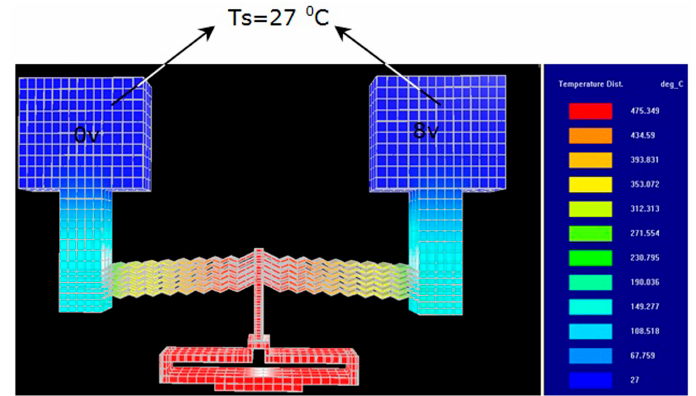
Figure 4. Geometry and boundary conditions of the proposed structure with simulation results obtained for temperature distribution (for half device